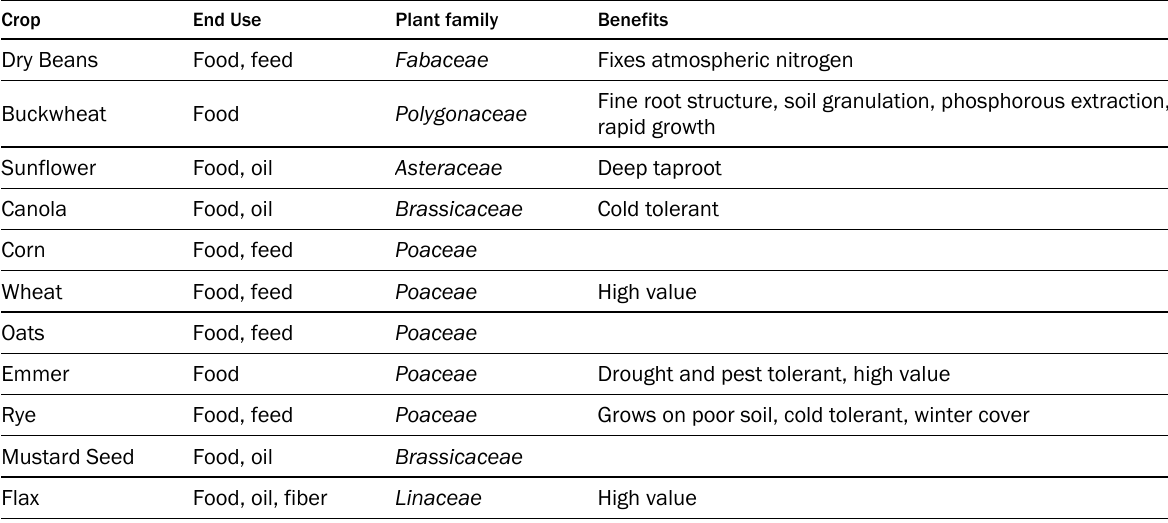
Table 1. Rotation Crops Suitable to the